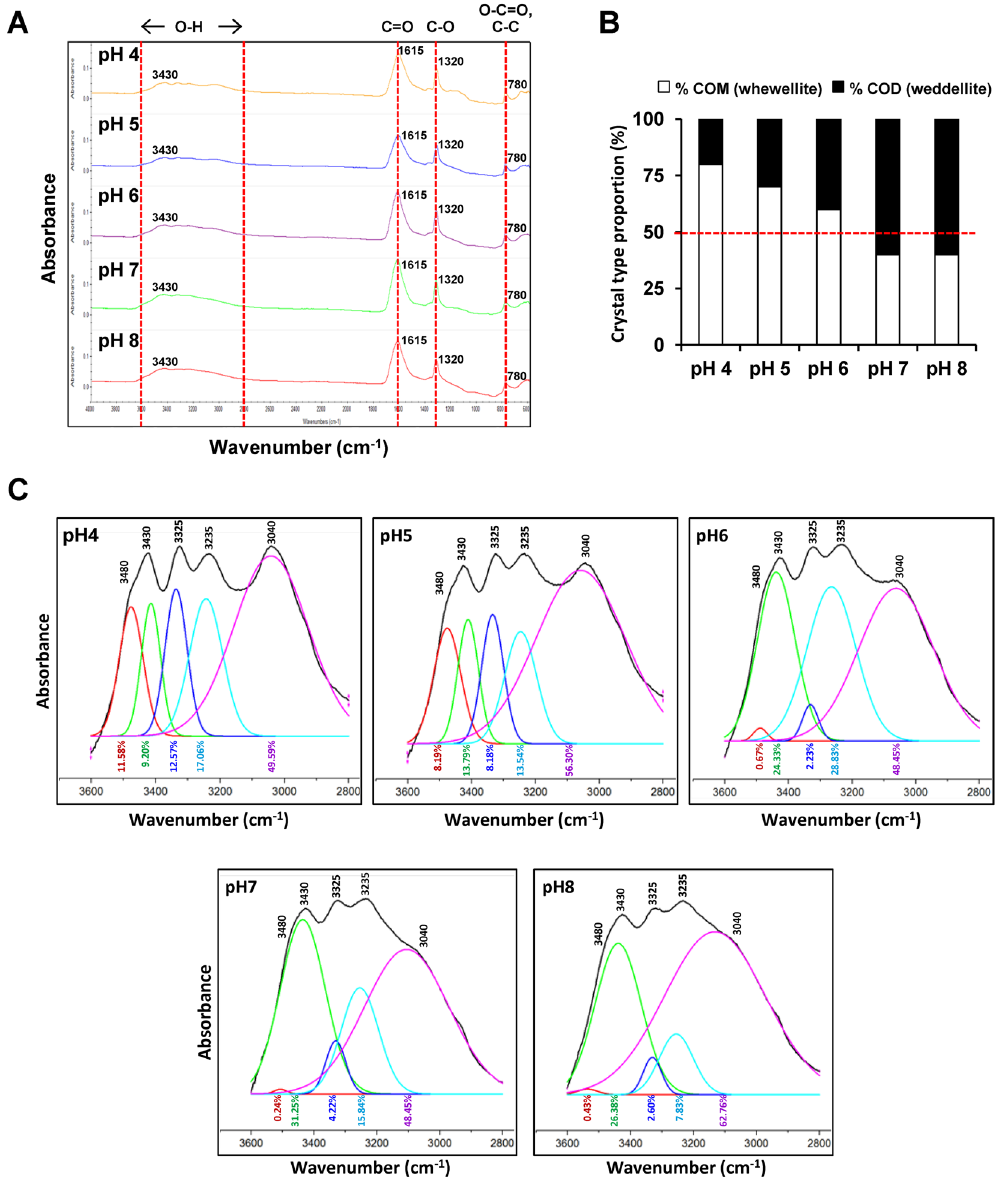
Figure 2. FT-IR spectra of CaOx crystallized in AU with various pH. ( A ) FT-IR spectra demonstrated the consistent spectra of CaOx. ( B ) Proportion of CaOx monohydrate (COM or whewellite) and dihydrate (COD or weddellite) slightly varied among different pH conditions. ( C ) Curve fitting analysis to differentiate pattern of “O-H” stretching between wavenumber of 3600–2800 cm − 1 of FT-IR